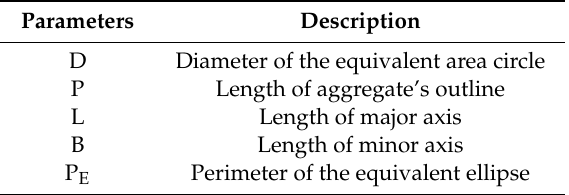
Figure 2. The recognition and analysis process of aggregates: ( a ) original image, ( b ) identified aggregates, ( c ) binarized aggregates, and ( d ) calculated aggregates. Table 4. The aggregate features parameters and its description.